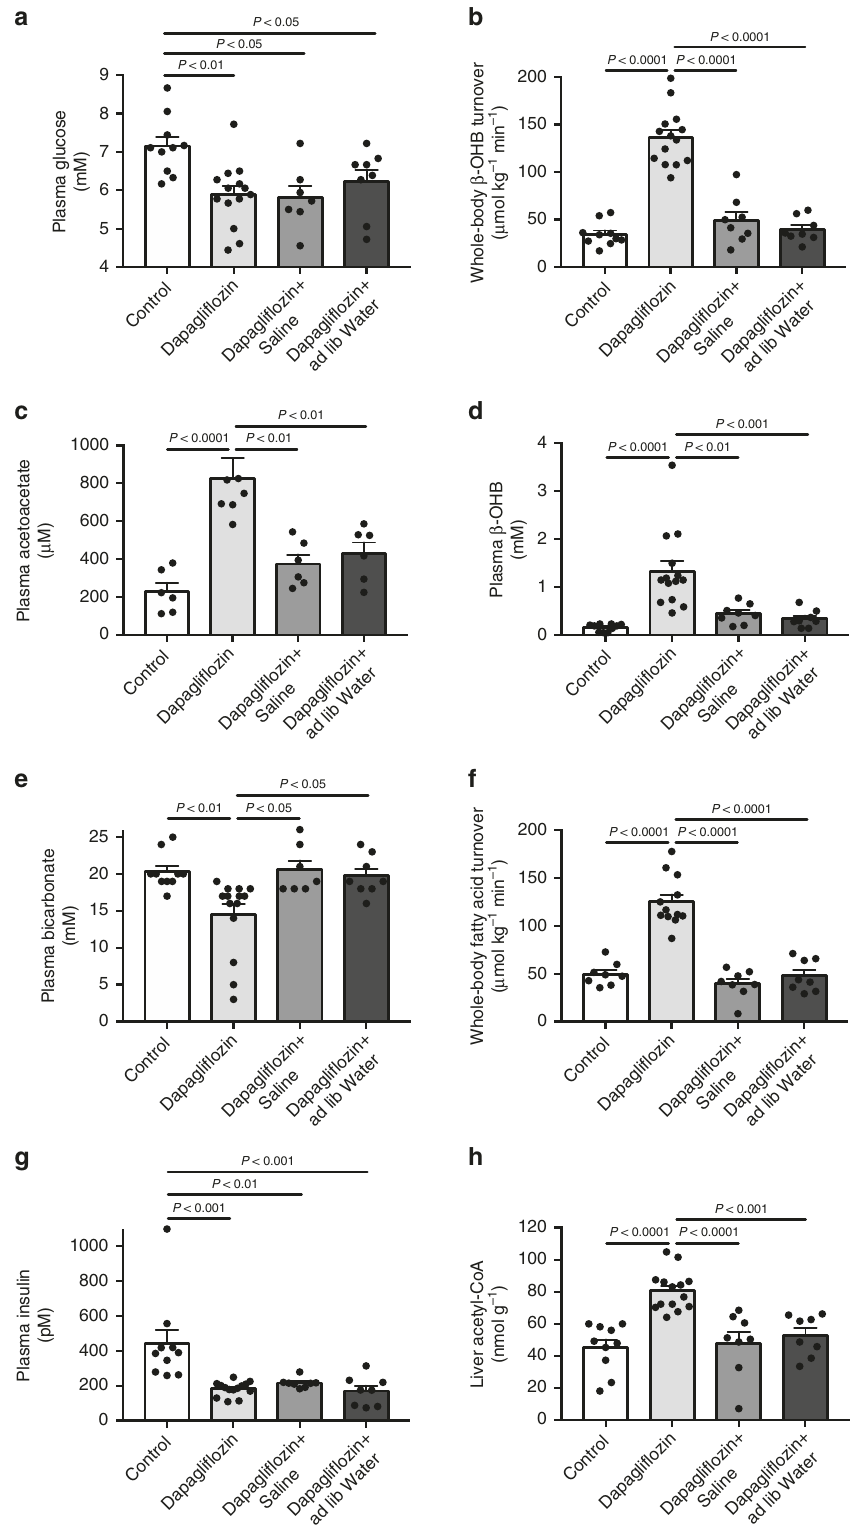
Fig. 1 Dapagli fl ozin causes increases in rates of hepatic ketogenesis and glucose production due to extracellular volume depletion. a – d Plasma glucose, bicarbonate, acetoacetate, and β -OHB concentrations. In panel c , n = 7 dapagli fl ozin-treated and n = 6 in all other groups. e , f Whole-body β -OHB and fatty acid turnover. g Plasma insulin concentrations. h Liver acetyl-CoA. Data are the mean ± S.E.M., and groups were compared by ANOVA with Bonferroni ’ s multiple comparisons